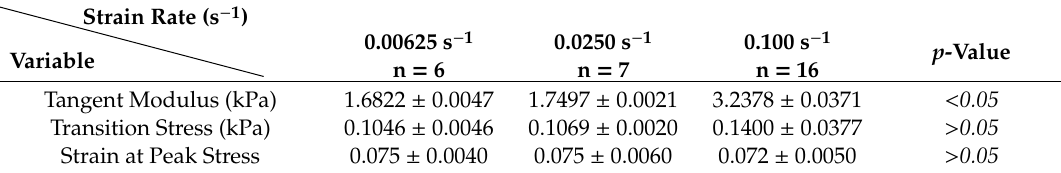
Table 5. Statistical comparison of the tangent modulus, elastic–inelastic transition stress ( σ t ) and strain at σ p / σ t of the wet brain (~80% m / m water content) at quasi-static and high strain rates. P < 0.05: significantly di ff erent; p > 0.05: significantly indi ff